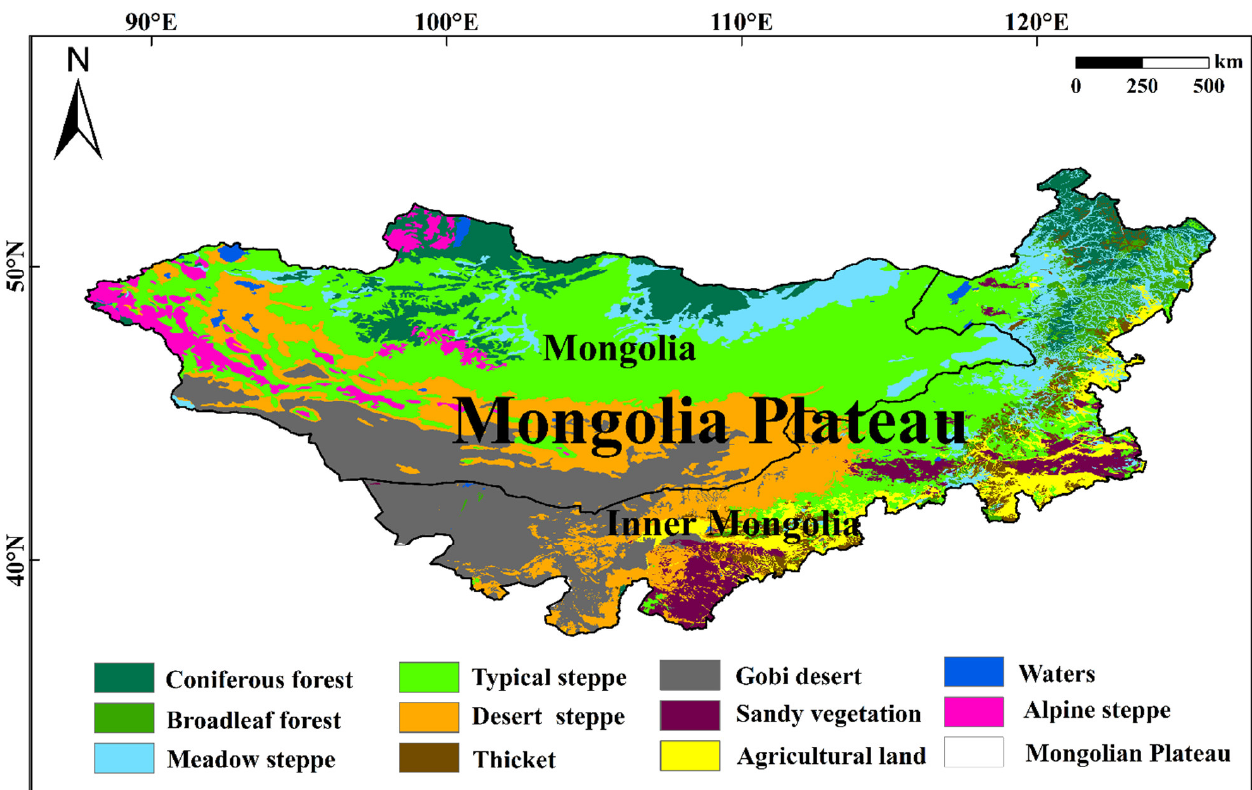
Figure 1. Land-type distribution map of the Mongolian Plateau.